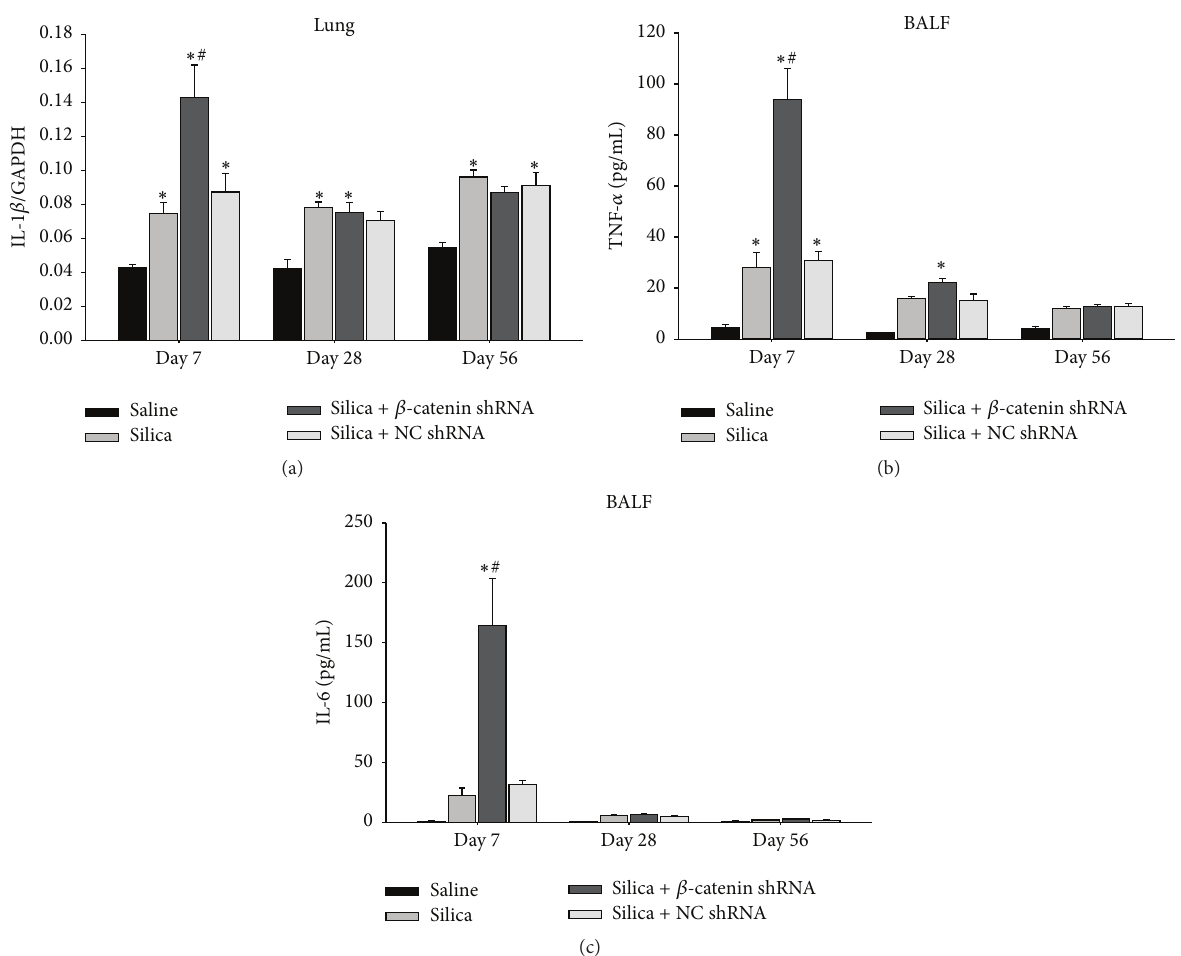
Figure 3: Blockade of Wnt/ 𝛽 -catenin pathway increased the production of proinflammatory cytokines. (a) Expression of IL-1 𝛽 mRNA in lung was assayed by real-time RT-PCR using the −ΔΔ Ct method. The concentrations of TNF- 𝛼 (b) and IL-6 (c) in BALF were assayed by flow cytometry using CBA Kit. Values are shown as mean ± SEM ( 𝑛 = 4 -5) ( ∗ , as compared with saline group at the same time point, 𝑝 < 0.05 ; #, as compared with silica group and silica + NC shRNA group at the same time point, 𝑝 < 0.05